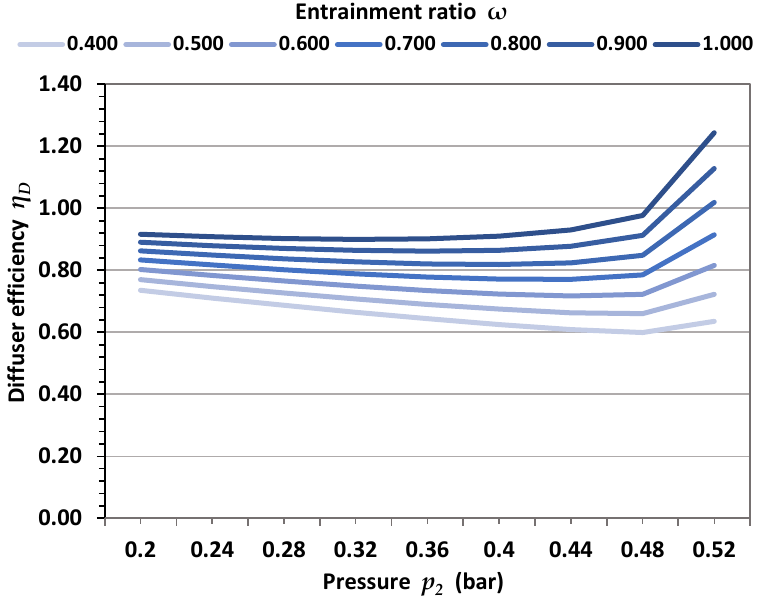
Figure 6. Function: 𝜂 (cid:3005) = 𝑓(𝑝 (cid:2870) ) parametric in ω .